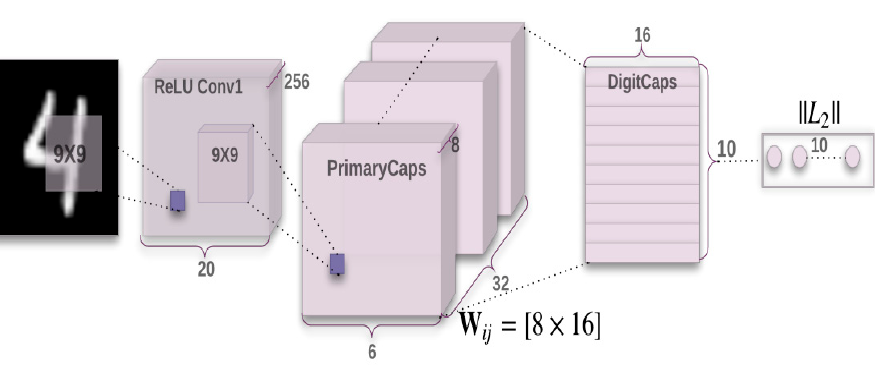
Figure 24. A simple CapsNet architecture [64].